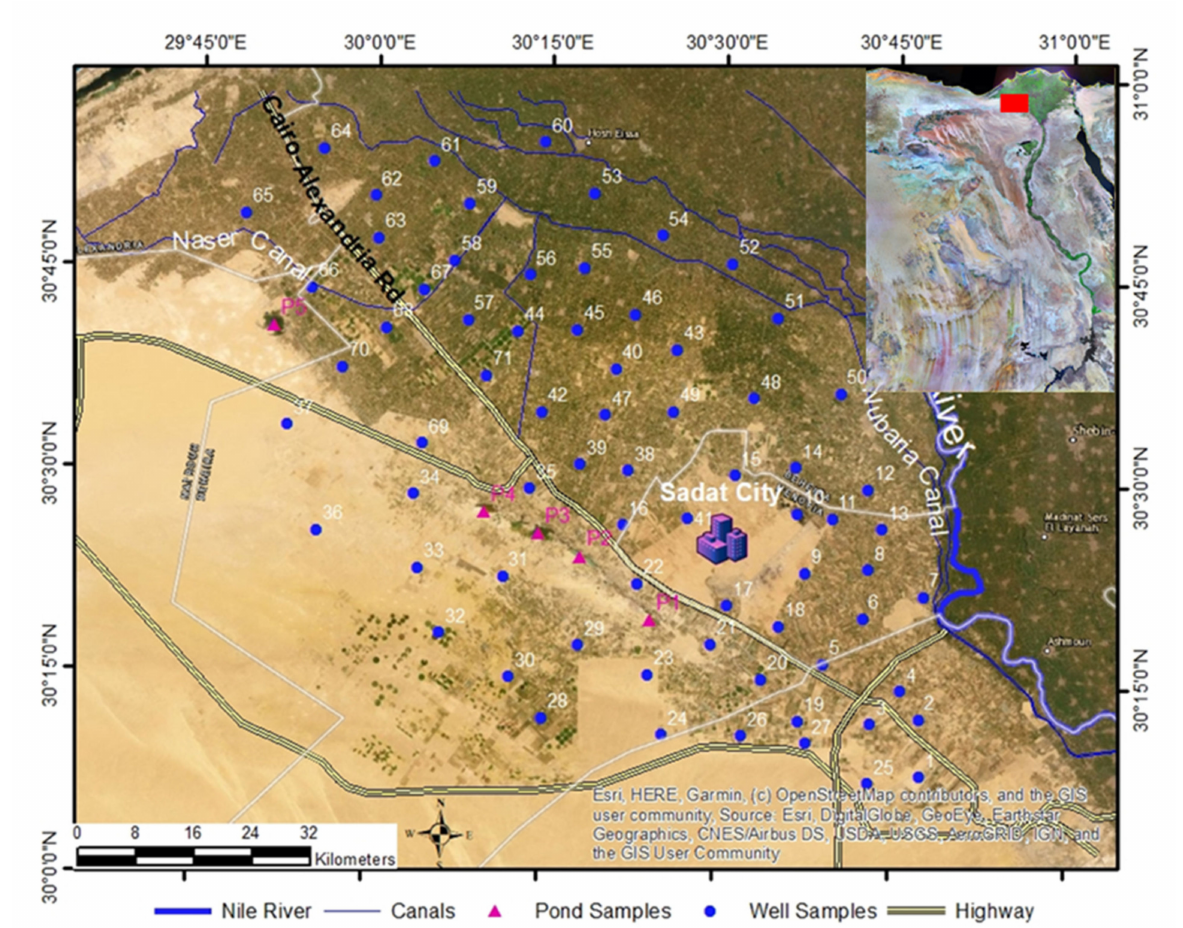
Figure 1. Location of the study area on the Environmental Systems Research Institute (ESRI) ArcGIS basemap. The image in the upper right corner is a false-color composite Landsat enhanced thematic mapper (ETM+) mosaic of Egypt. The red rectangle is the location of the study